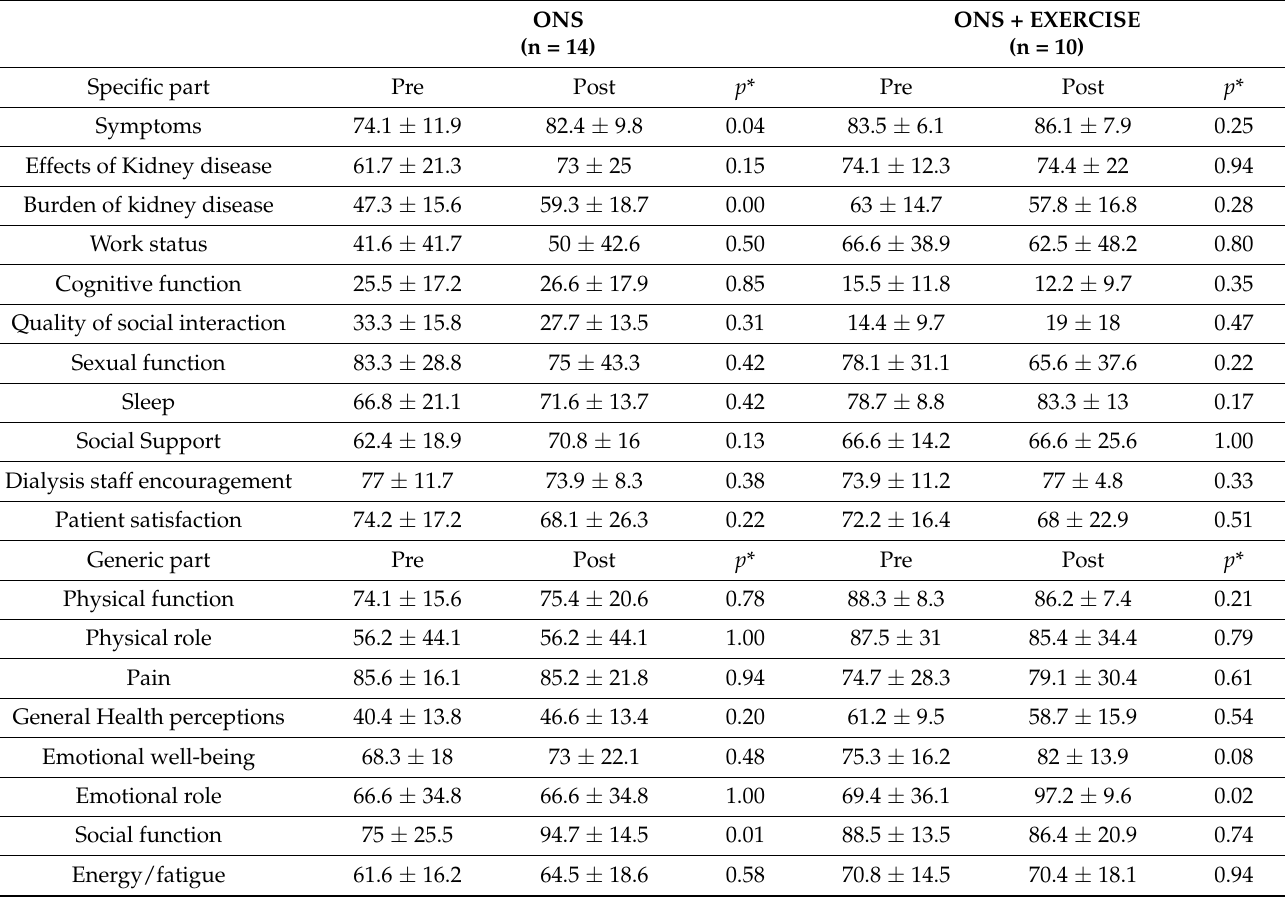
Table 4. Changes in the quality of life measured with KDQOL SF-26. ONS (n = 14)